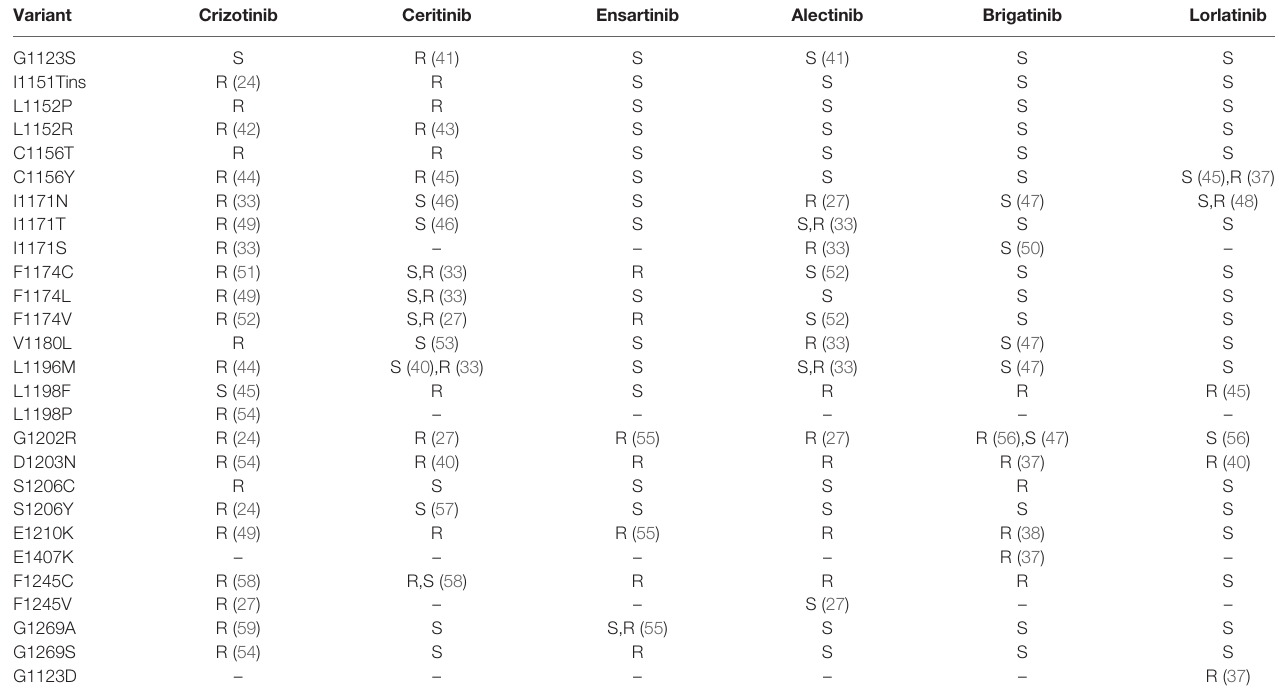
TABLE 2 | Resistant and sensitive mutations of 6 ALK inhibitors (S, sensitive; R, Resistance).